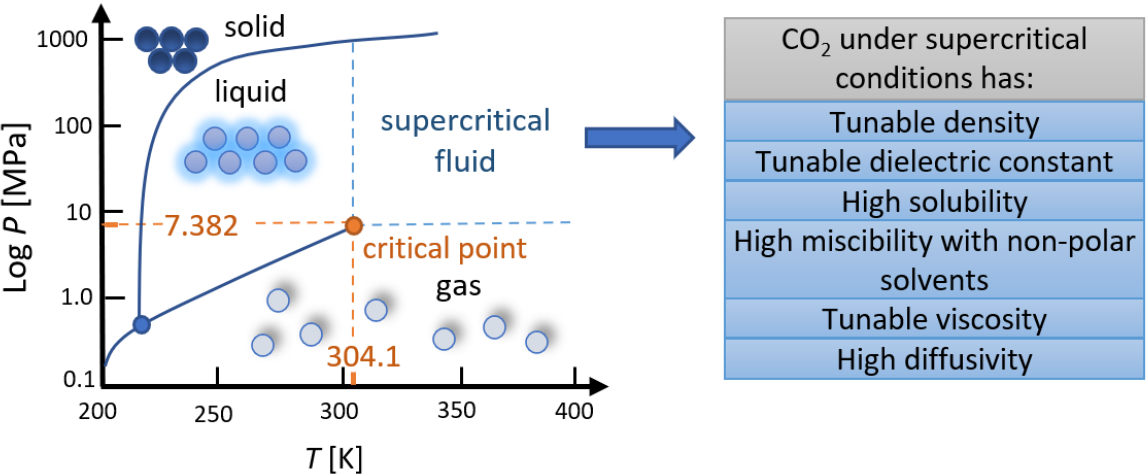
Figure 1. Phase diagram of CO 2 and its advantageous characteristics at supercritical conditions. Adapted from [22].